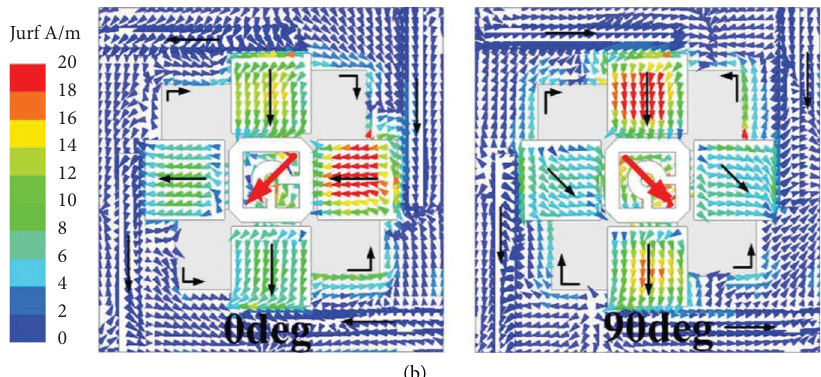
Figure 5: Simulated vector electric feld distribution in the CP MSA and its corresponding principal planes with diferent phases of 0 ° and 90 ° at (a) 5.35GHz and (b) 6.35GHz,